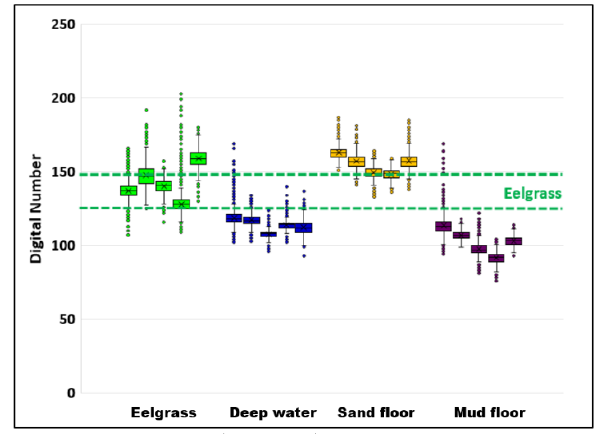
Figure 8: Channel 1 (blue band) comparison of the DN values for the four classes in the PCI Geomatica RGB mosaic of Shediac Bay. The green dashes indicate the range of DN values that correspond to